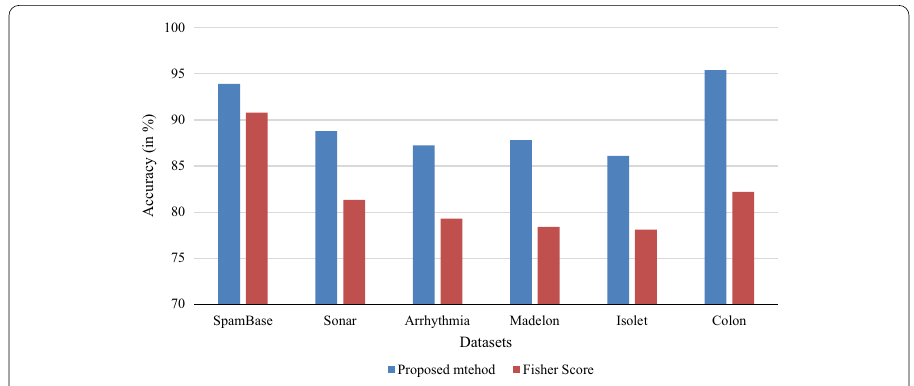
Fig. 6 Comparing the accuracy of the proposed method with the Fisher Score